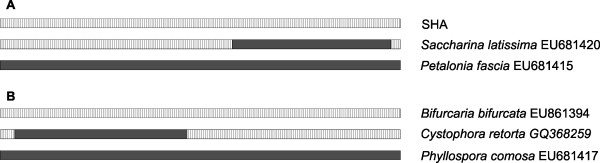
Schematic representation of recombination events in the COI gene region from Saccharina latissima (A) and Cystophora retorta (B).  The parental sequences are from Petalonia fascia  and the SHA form (for S. latissima ); and Bifurcaria bifurcata  and Phyllospora comosa  (for C. retorta ).